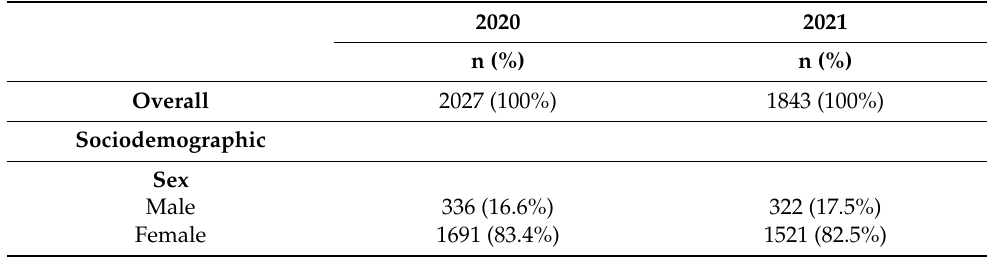
Table 1. Sociodemographic and occupational characterization of